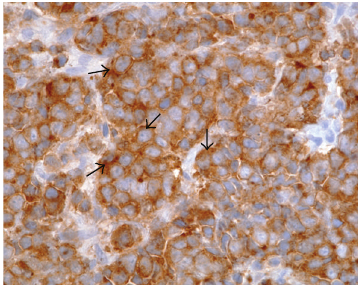
Figure 5: Positive synaptophysin stain, consistent with neuroen- docrine origin (see